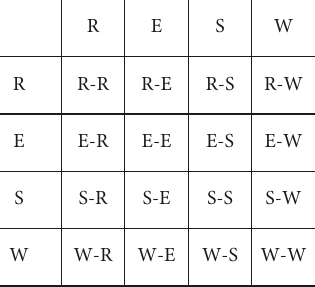
Figure 5: The coupling matrix of multilayer networks.